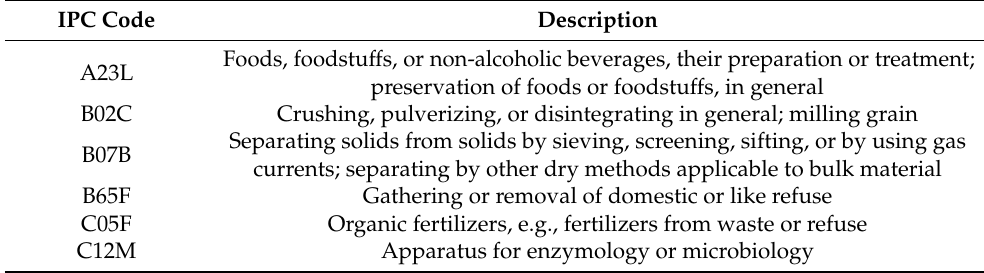
Table 6. Descriptions of selected IPC codes used in the search